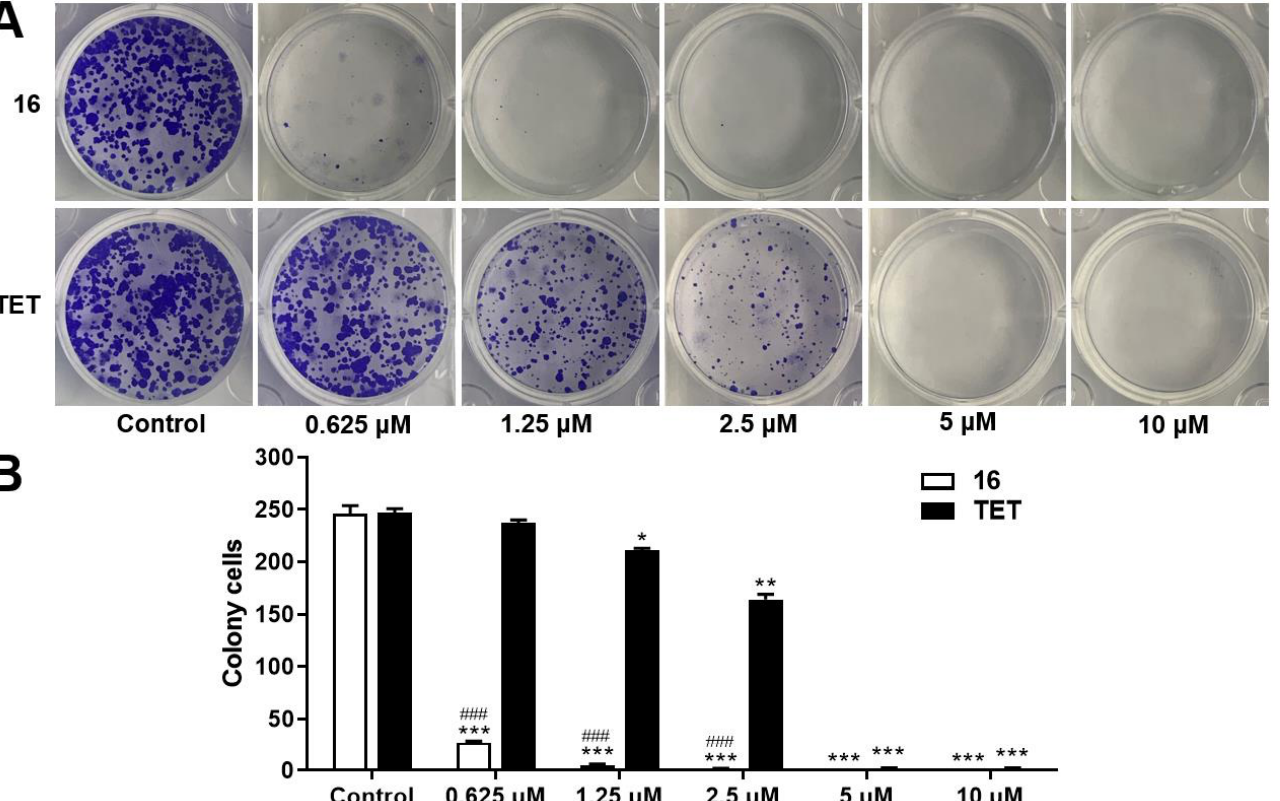
Figure 3. Inhibitory effect of 16 on the colony formation of HCT-15 cells. ( A ) HCT-15 cells were incubated with varying concentrations of 16 (0.625 1.25, 2.5, 5, and 10 μ M) for 10 d, and the colonies were stained with crystal violet. ( B ) Quantifications of colony numbers. *: p < 0.05, **: p < 0.01, ***: p < 0.001, vs. control group; ### : p < 0.001, vs. TET at the same concentration.